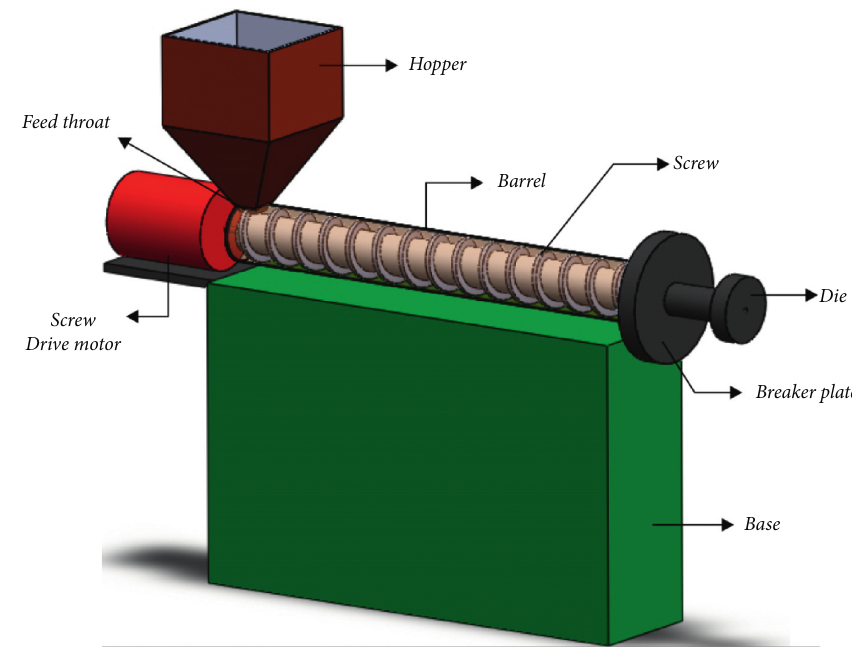
Figure 2: Schematic of the twin screw extrusion process.